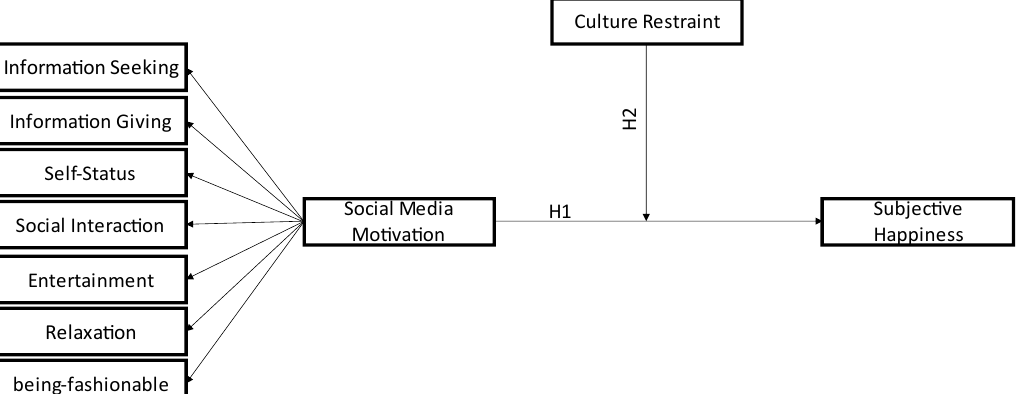
Figure 1. Research framework based on theoretical framework tested on subjective happiness.